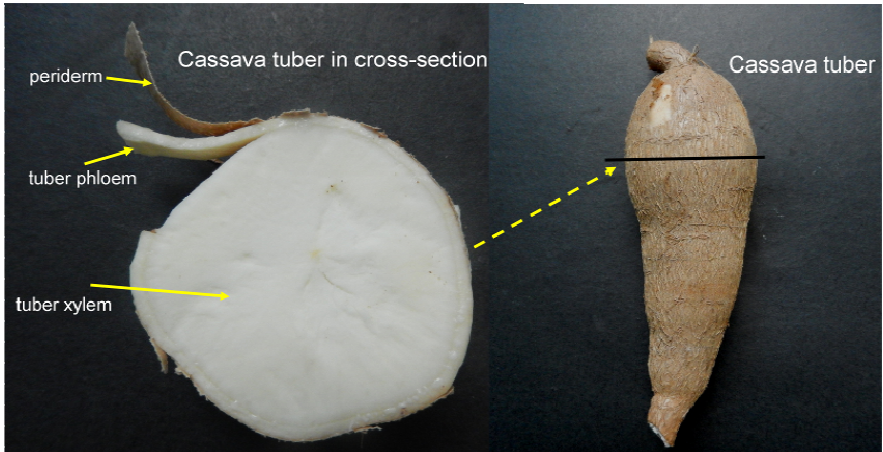
Figure 11. Separation of the cassava tuber phloem and tuber